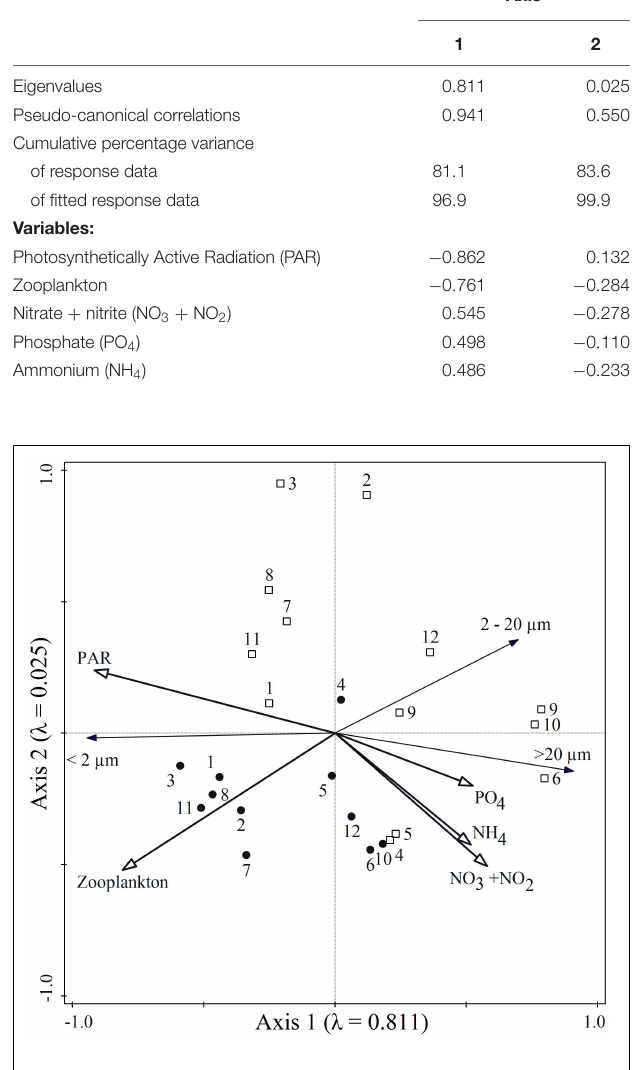
FIGURE 5 | Redundancy analysis (RDA) of factors influencing the size-structure of the phytoplankton community during the middle and end of the experiment. The distribution of pico- ( < 2 µ m), nano- (2–20 µ m) and micro- ( > 20 µ m) phytoplankton were analyzed in relation to zooplankton biomass (Zooplankton), phosphate (PO 4 ), ammonium (NH 4 ), nitrate + nitrite (NO 3 + NO 2 ) and Photosynthetically Active Radiation (PAR). Numbers display mesocosm numbers (Ctr L (1,2,7), Ctr H (3,8,11), tM L (4,5,12), tM H (6,9,10),